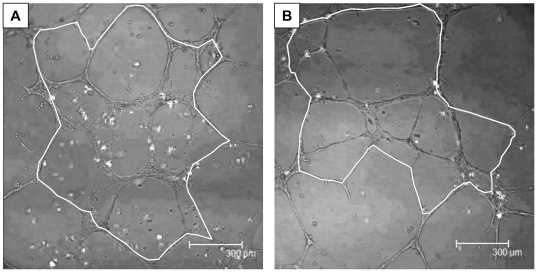
Tubule formation assay in healthy controls (A) and PCOS (B) patients.Panels A and B are representative pictures of the tubule network formed by the VPC (white dots) and HUVECs. The white line represents the surface area which was measured i.e. area formed by complete closed tubes.